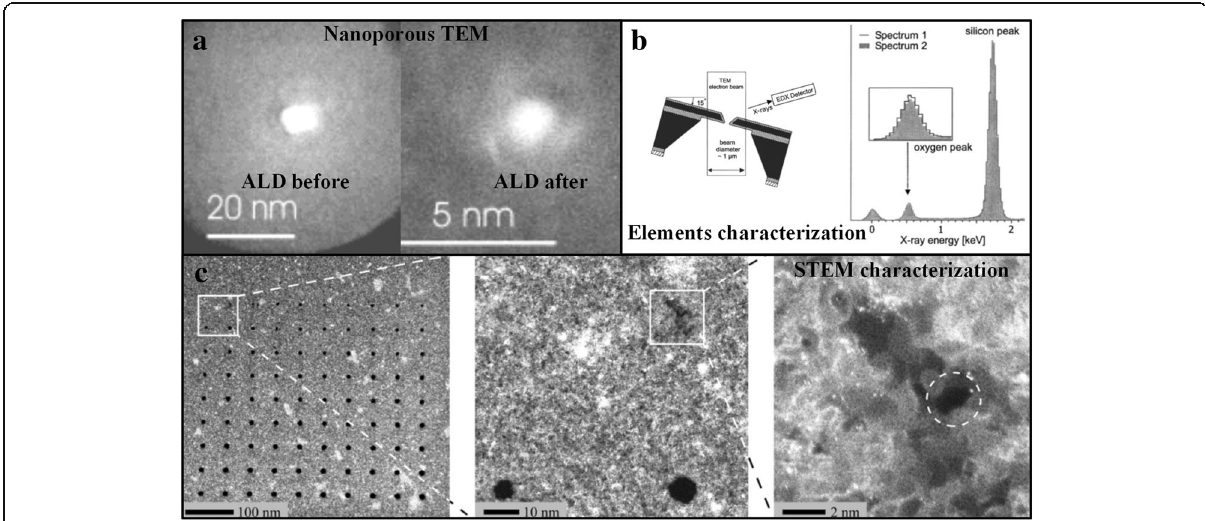
Fig. 4 High-energy particle etching and modification methods for the fabrication of solid-state nanopore. ( a ) ALD shrinkage, ( b ) self-calibration of nanopore edge, and ( c ) helium ion etching